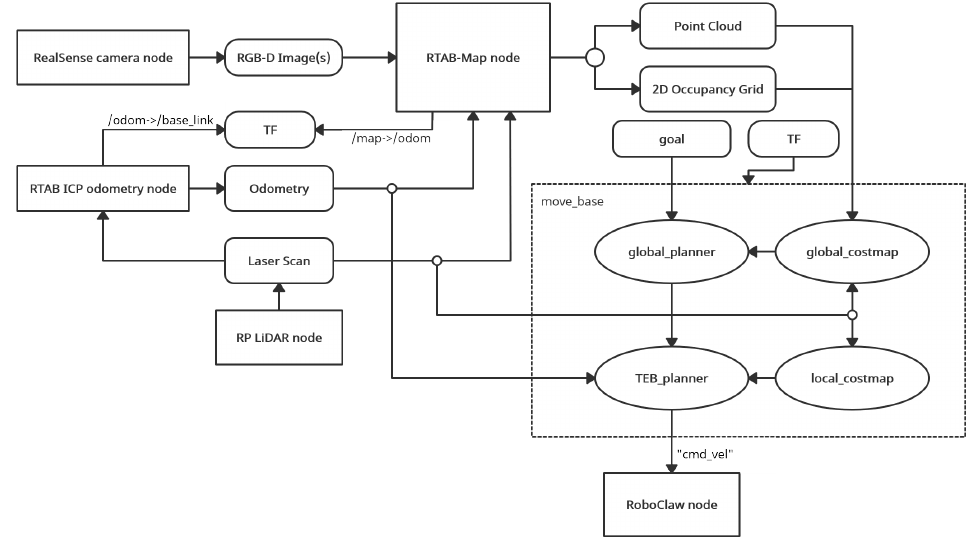
Figure 3. Organization of ROS nodes in mobile robot ROS network